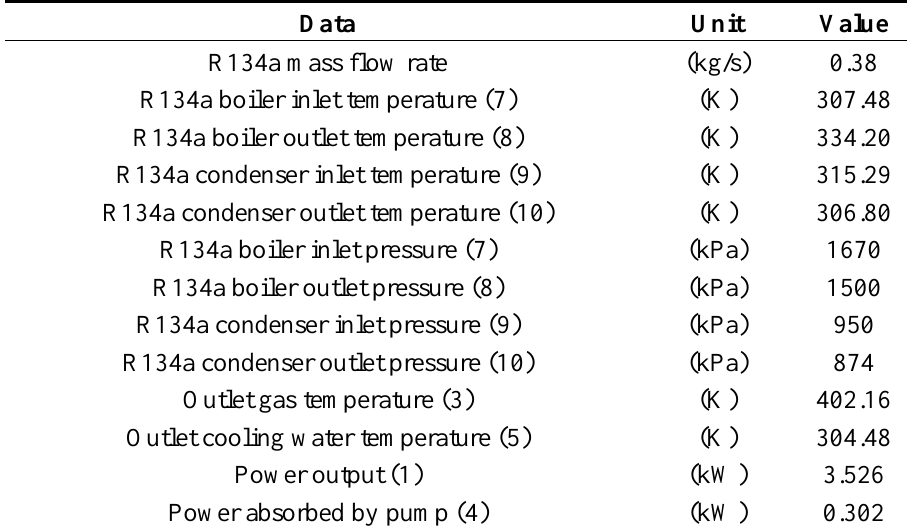
Table 3. Simulation results the of R134a case.